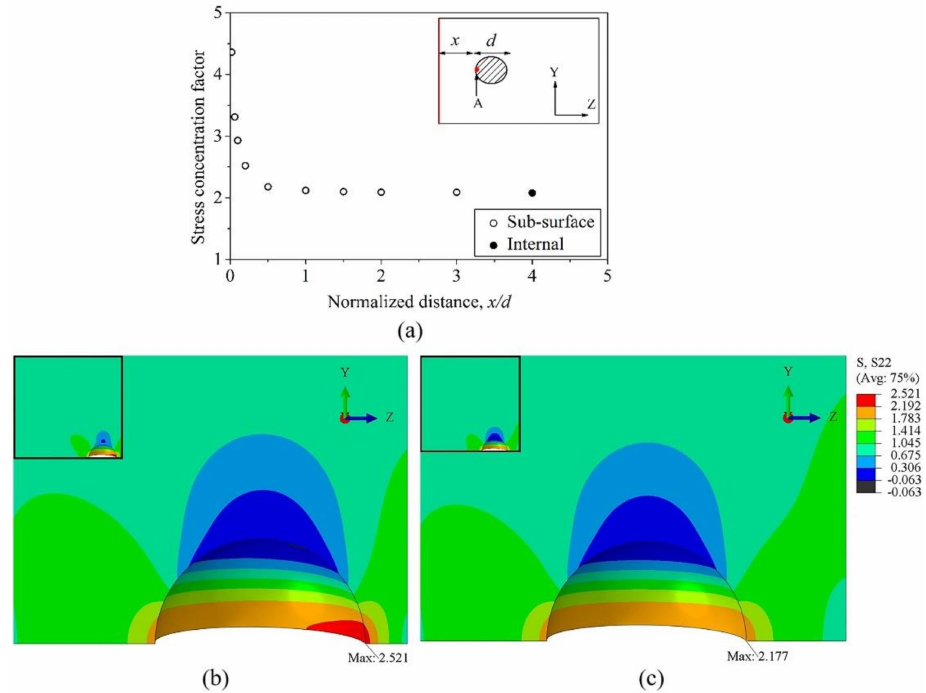
Figure 22. Subsurface pore of diameter d: ( a ) stress concentration factor, Kt vs. distance, x to free surface (point A, marked as dot), ( b , c ) overall model (top left corner) and enlarged view of local stress distribution under applied unit stress in the Z-X plane; x = 0.2 d, Kt = 2.52 in ( b ), x = 0.5 d, Kt = 2.18 in ( c ). Reprinted with permission from ref. [77]. 2018,